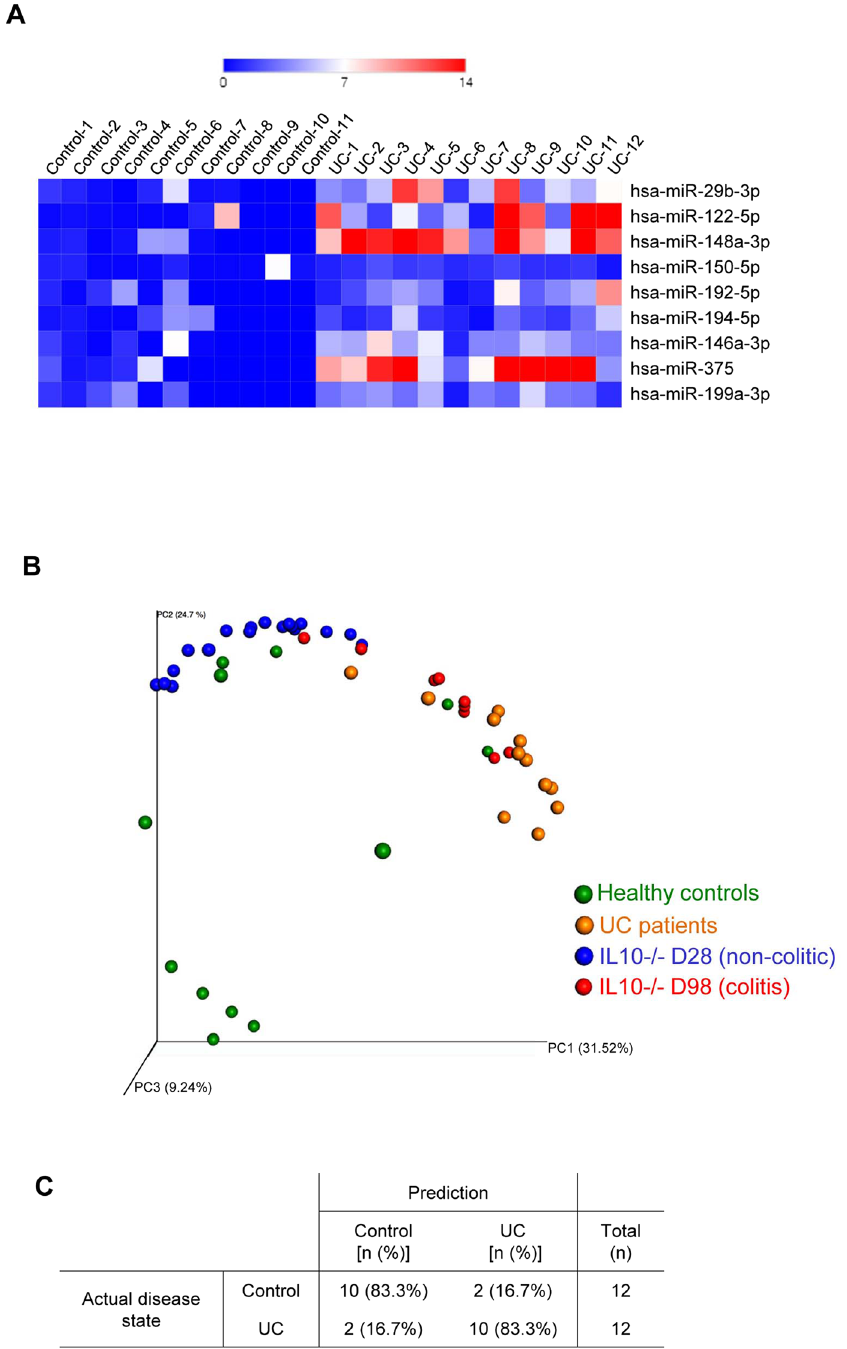
Figure 6. miRNA signature in UC patients. The expression levels of 9 deregulated miRNAs were assesses by qPCR in UC patients. ( A ) Heatmap showing the relative fold changes over controls of the 9 miRNAs in each sample. ( B ) PCoA of the bray curtis distance of miRNA expression in sera from non-colitic mice (in blue), colitic mice (in red), Ulcerative colitis (UC) patients and healthy control. ( C ) kNN (k-Nearest Neighbour) classifier were applied using mice samples (both colitic and non colitic) as discovery cohort and human samples (both UC and controls) as test cohort. Prediction rates of disease state using the previously identified miRNA signature is